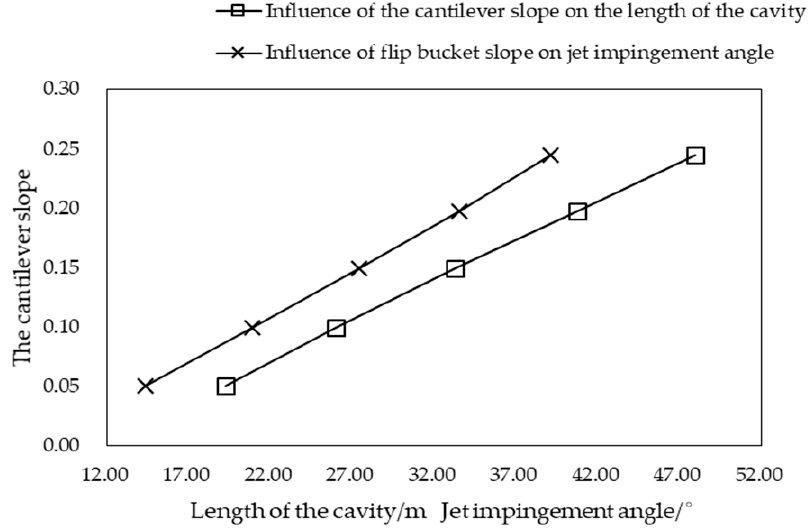
Figure 5. Relationship between different the cantilever slope and cavity length.